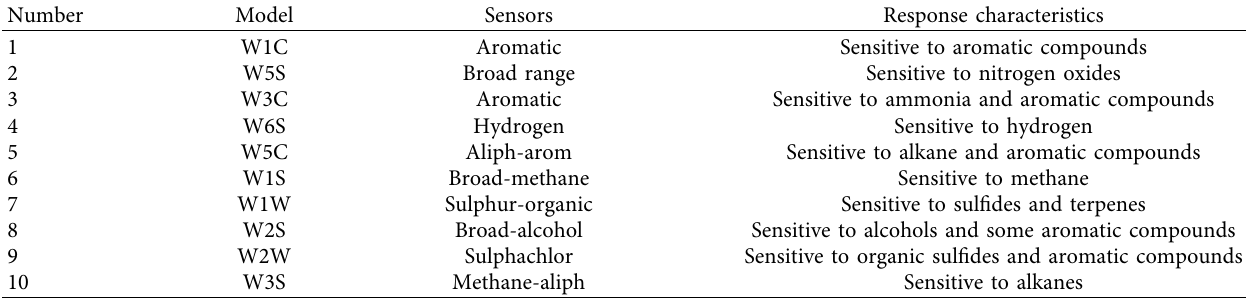
Table 2: Response characteristics of electronic nose sensor PEN3.